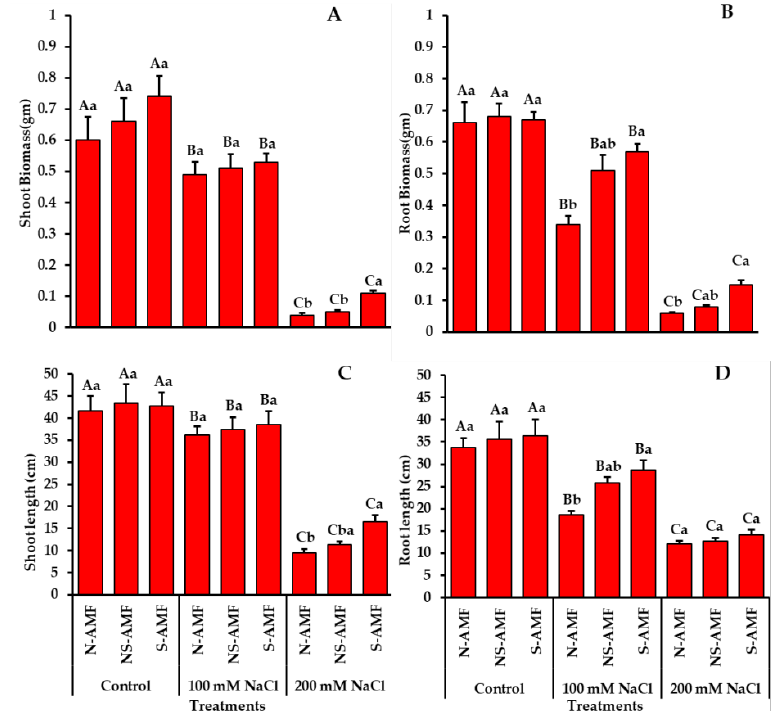
Figure 3. Showing the effect of AM symbiosis (S-AMF and NS-AMF) on the growth parameters such as shoot biomass ( A ), root biomass ( B ), shoot length ( C ), and root length ( D ) of L. scindicus plants cultivated under different salinity levels. Capital letters indicate the significance of the salinity effect, while small letters indicate the effect of AM symbiosis at p = 0.05 (Tukey’s HSD test).